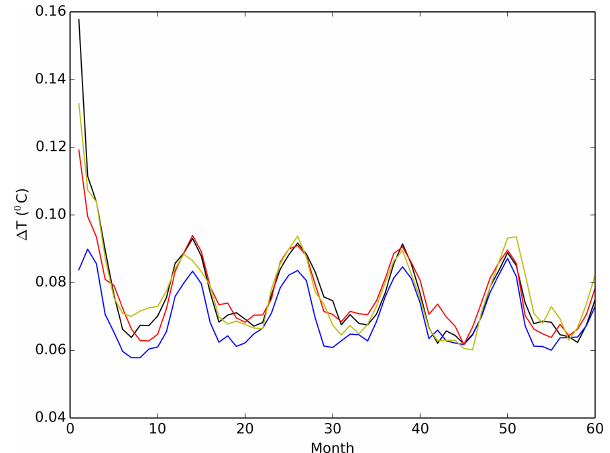
Figure 2. Monthly time series of temperature difference across ice fronts averaged over depth and along the entire Antarctic coast in the first 5 years of ocean stand-alone integration (Stage C) for all (four) members. The blue line is the member that was not initialised with the global ocean from the UKESM1.0 CMIP6 historical en-